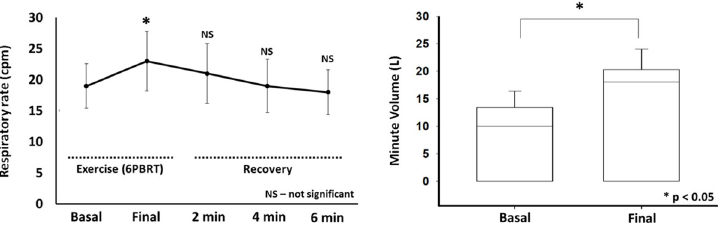
Fig 4. Respiratory rate and minute volume responses. Abbreviations: cpm, cycles per minute; 6-PBRT, six-minute pegboard and ring test; NS, not significant; L, liters; min, minutes; � significant difference when compared to basal